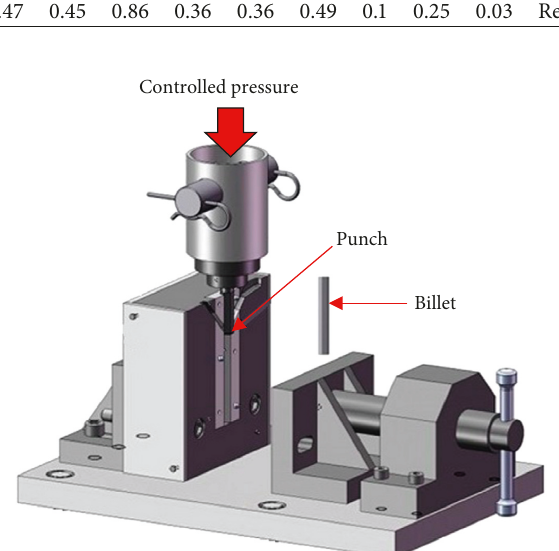
Figure 1: Schematic presentation of squeeze casting